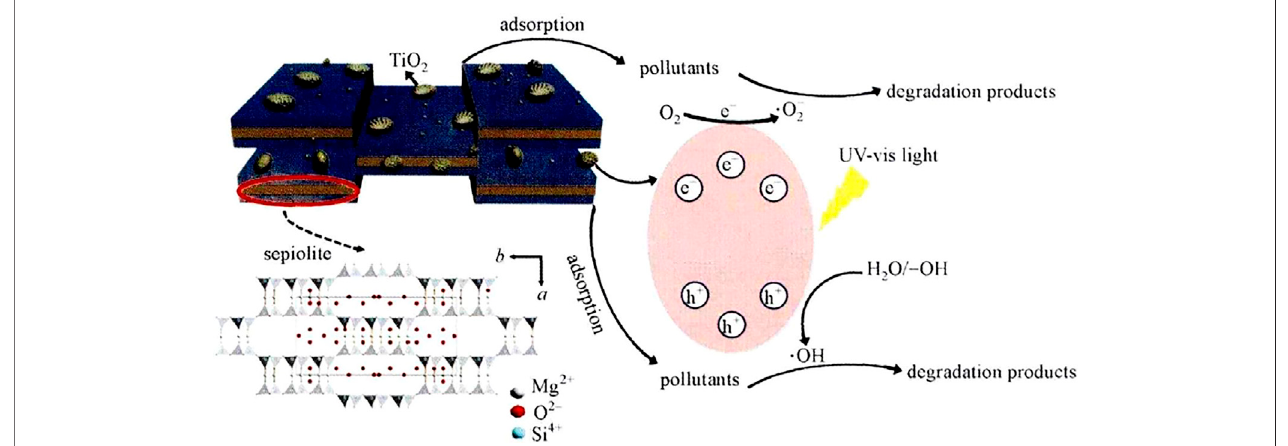
FIGURE 4 | Catalytic degradation mechanism diagram of TiO 2 /sepiolite composite material (Liu R. et al., 2018)